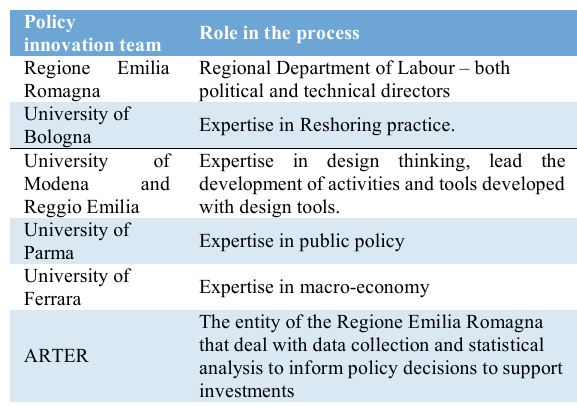
Table 2. Team in charge of designing the methodology behind the policy.